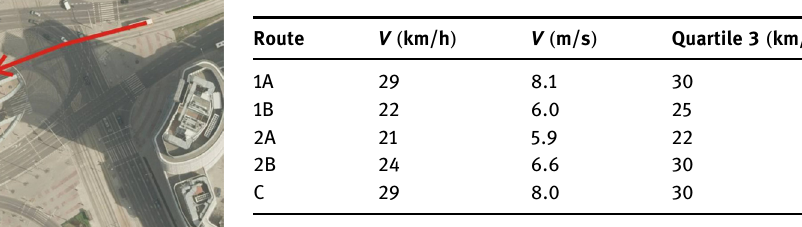
Table 4: Average tram speed when entering a level crossing on transport